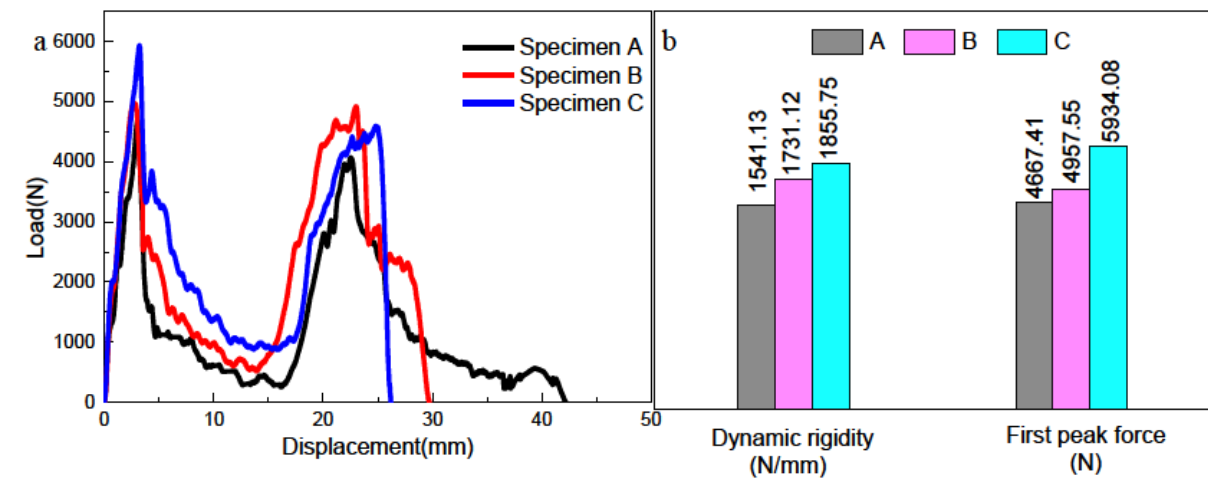
Figure 10: The load displacement curve (a) and impact response (b) under the impact energy of 60